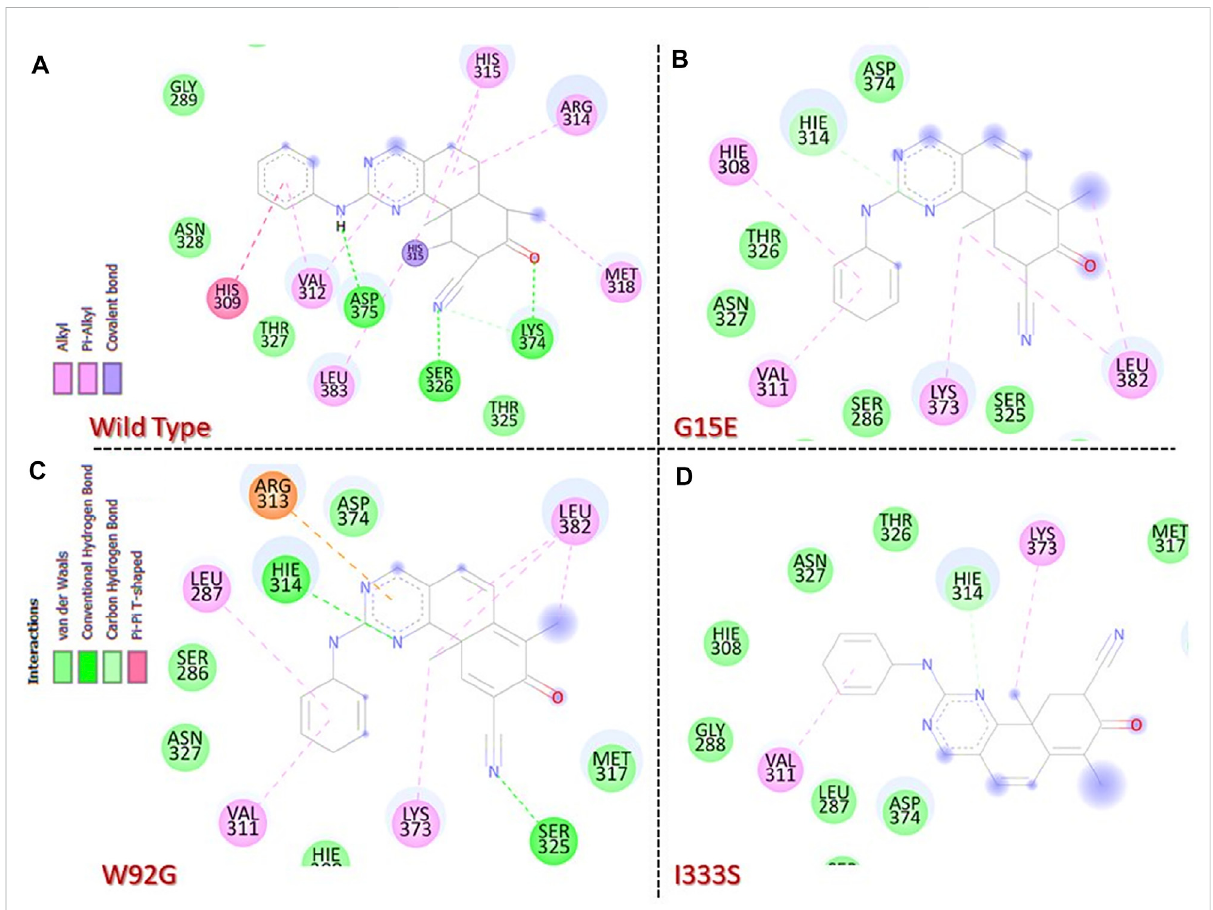
FIGURE 3 Molecular docking analysis of the wild-type and mutant complexes. (A ) Representation of the interaction pattern of the wild type. (B) Representation of the interaction pattern of G15E. (C) Representation of the interaction pattern of W92G. (D) Representation of the interaction pattern of